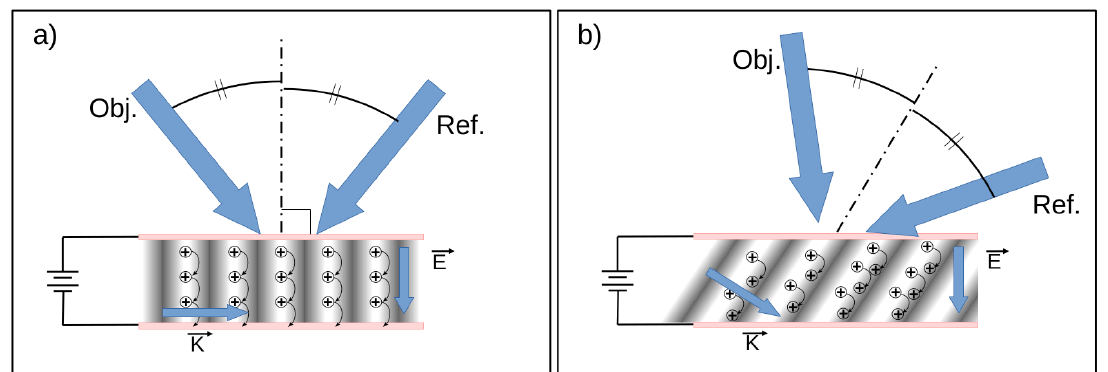
Figure 5. Geometry of the external field ( (cid:126) E ) with respect to the grating vector ( (cid:126) K ). ( a ) When the grating vector is orthogonal to the external electric field, the charges generated in the bright regions are driven towards the opposite electrode where they are collected. No space-charge field is created, and no diffraction is observed. ( b ) By tilting the grating vector, the charges are pulled toward the dark regions of the grating where they can be trapped, forming the space-charge